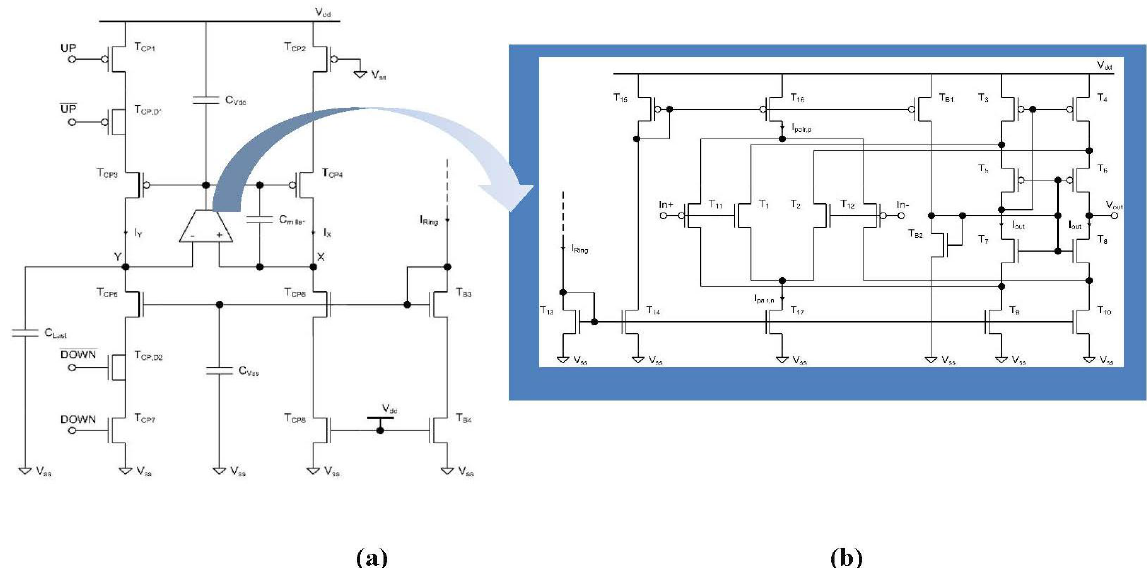
Figure 6. ( a ) Structure of improved chargepump. ( b) and the used operational transconductance amplifier